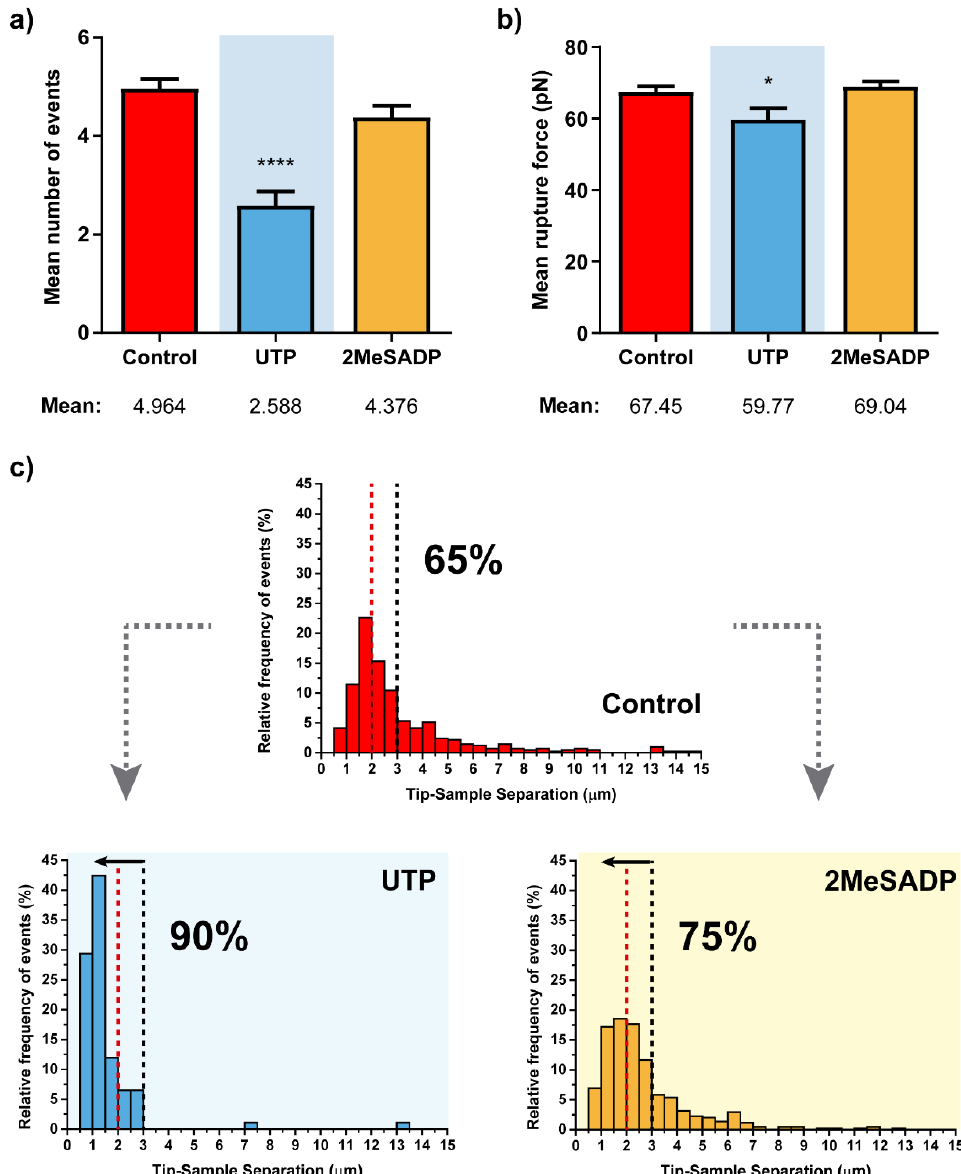
Figure 2. Rupture event and tether characterization for the respective treatments on HUVEC cells ( N > 15). Figures ( a ) and ( b ) show the mean ±S.E.M. values for the number of tethers per curve and the rupture force. ( c ) Pulling distance- dependent relative frequency of appearance of full rupture events under the different conditions. Dashed lines highlight the maximum probability to find rupture events in control HUVEC cells (red) and the position at which observation of the 90% of the tethers in UTP-treated cells takes place, with the respective percentages in each case. Statistically relevant variations p < 0.05 and p < 0.0001 are highlighted by * and ****, respectively.